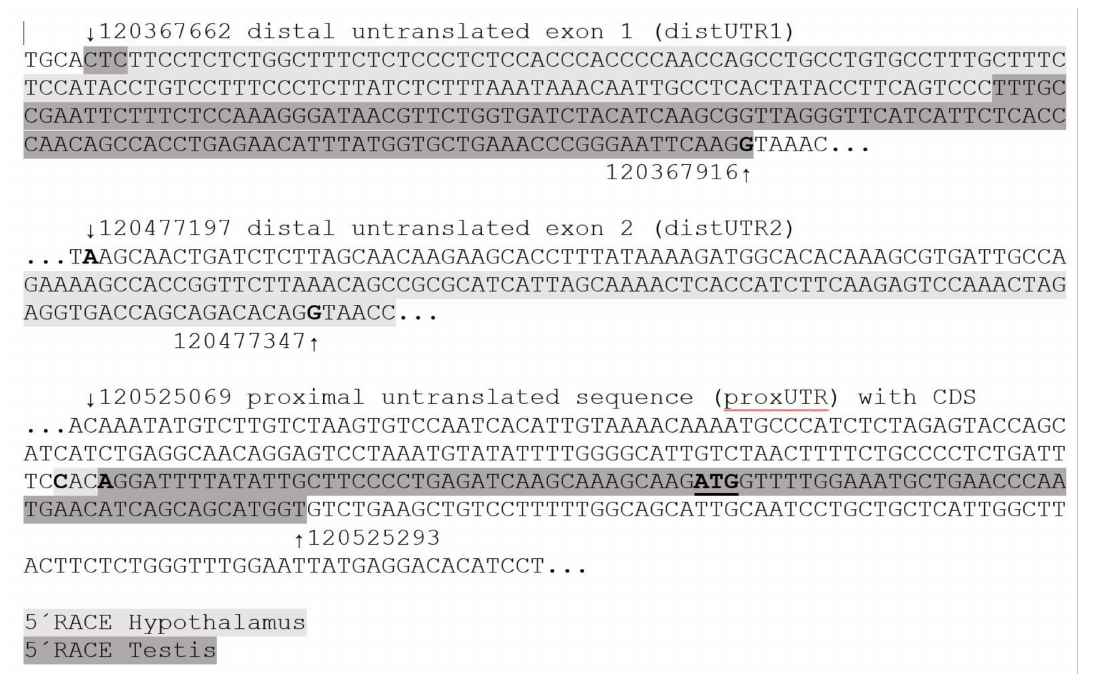
Figure 1. Distal and proximal untranslated regions and partial coding sequence of CYP19A3 . Here, 5 ´ RACE and RT-PCR products from porcine female and male gonads and hypothalami with high similarities ( ≥ 97%) were mapped to the pig genomic sequence. ↓ and ↑ indicate position numbers of selected nts in the pig genomic contig NC_010443.5 of Chromosome 1. Regions with sequence similarities to 5 ´ RACE clones from hypothalamus (grey) and testis (dark grey) are highlighted. Presumptive splice sites and the first codon (ATG) of CYP19A3 are printed in